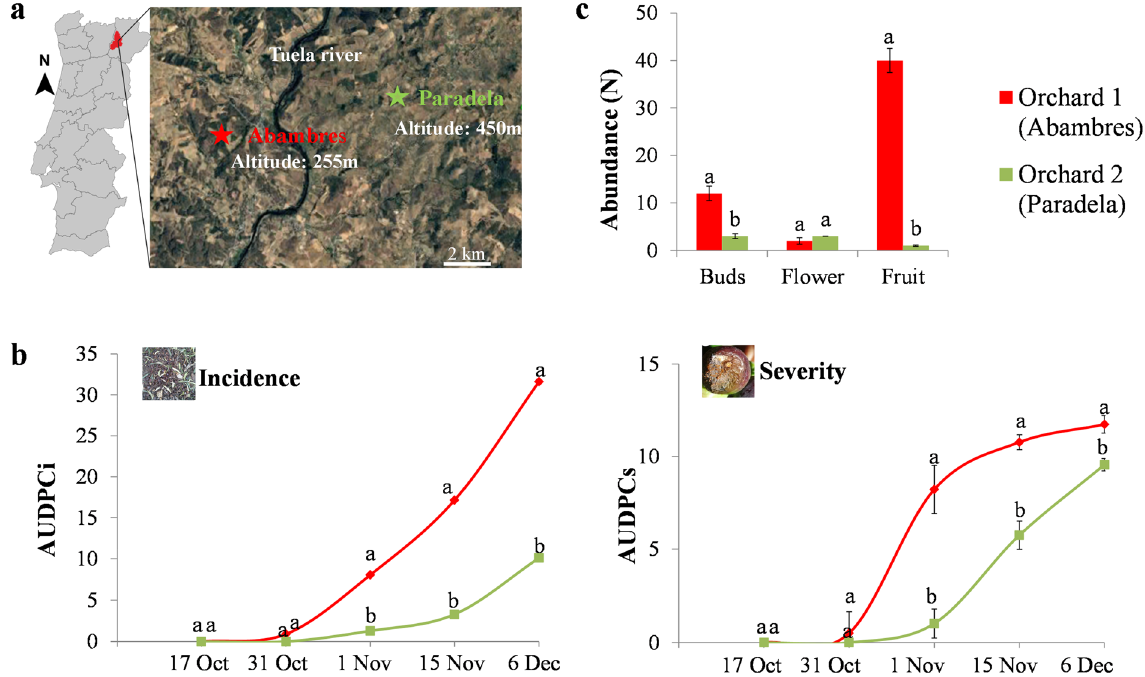
Figure 1. Olive orchards used for the isolation of endophytic fungi from flower buds, flowers and fruits of olive tree. ( a ) Google map showing the localization of the two olive orchards—orchard 1 (Abambres) and 2 (Paradela) in the Northeast of Portugal (retrieved on 10th December 2019, from https ://www.googl e.pt/maps/); ( b ) Area under the disease progress curve of incidence (AUDPCi) and severity (AUDPCs) of olive anthracnose evaluated in both orchards during the autumn–winter period of 2016; ( c ) Abundance of Colletotrichum spp. in flower buds, flowers and fruits of olive trees from the two orchards. Data points with different letters indicate statistically significant differences (at least p < 0.05) between the two olive